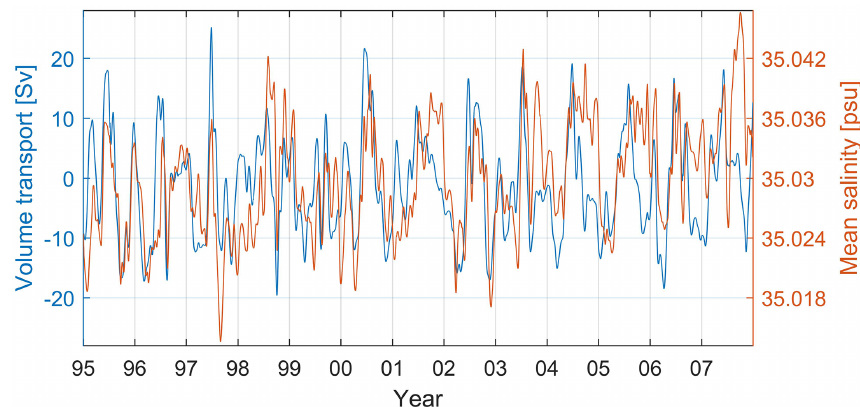
Figure 7. Time series of volume transport (blue) and mean salinity (orange) between 81.5 and 82.5 ◦ E over the 200–1000m layer from